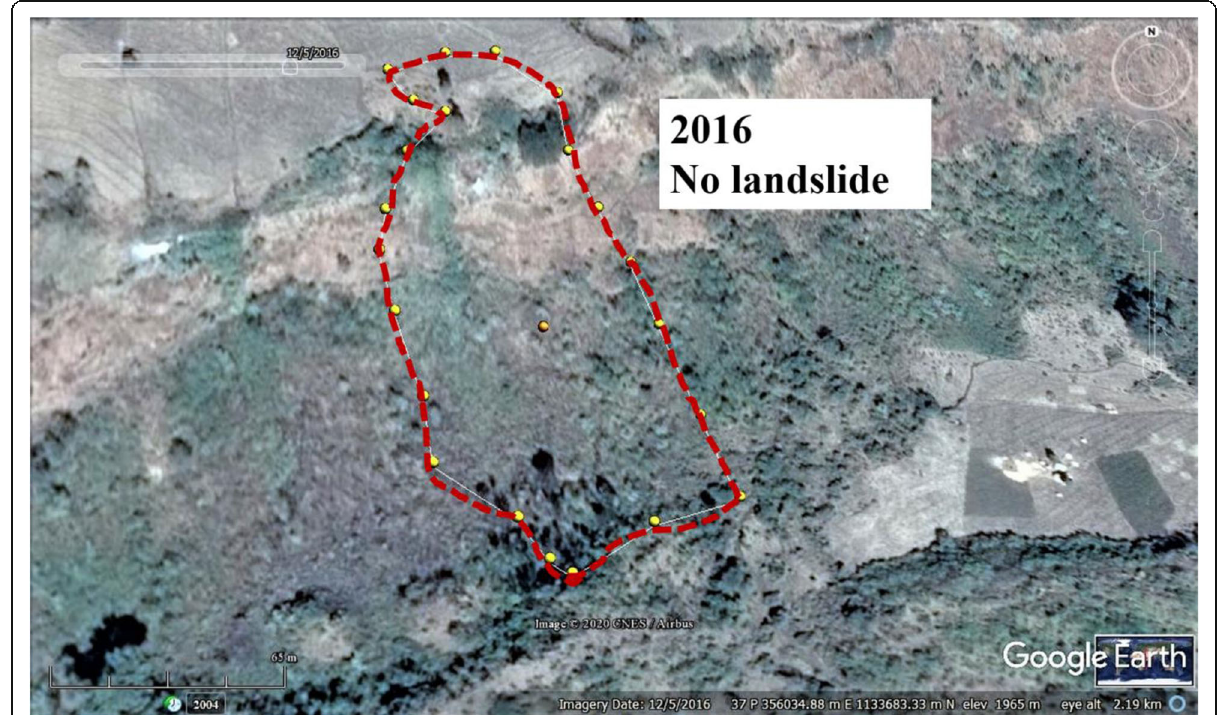
Fig. 9 Time series Google Earth Image shows unfailed slope at Aba Libanos village in